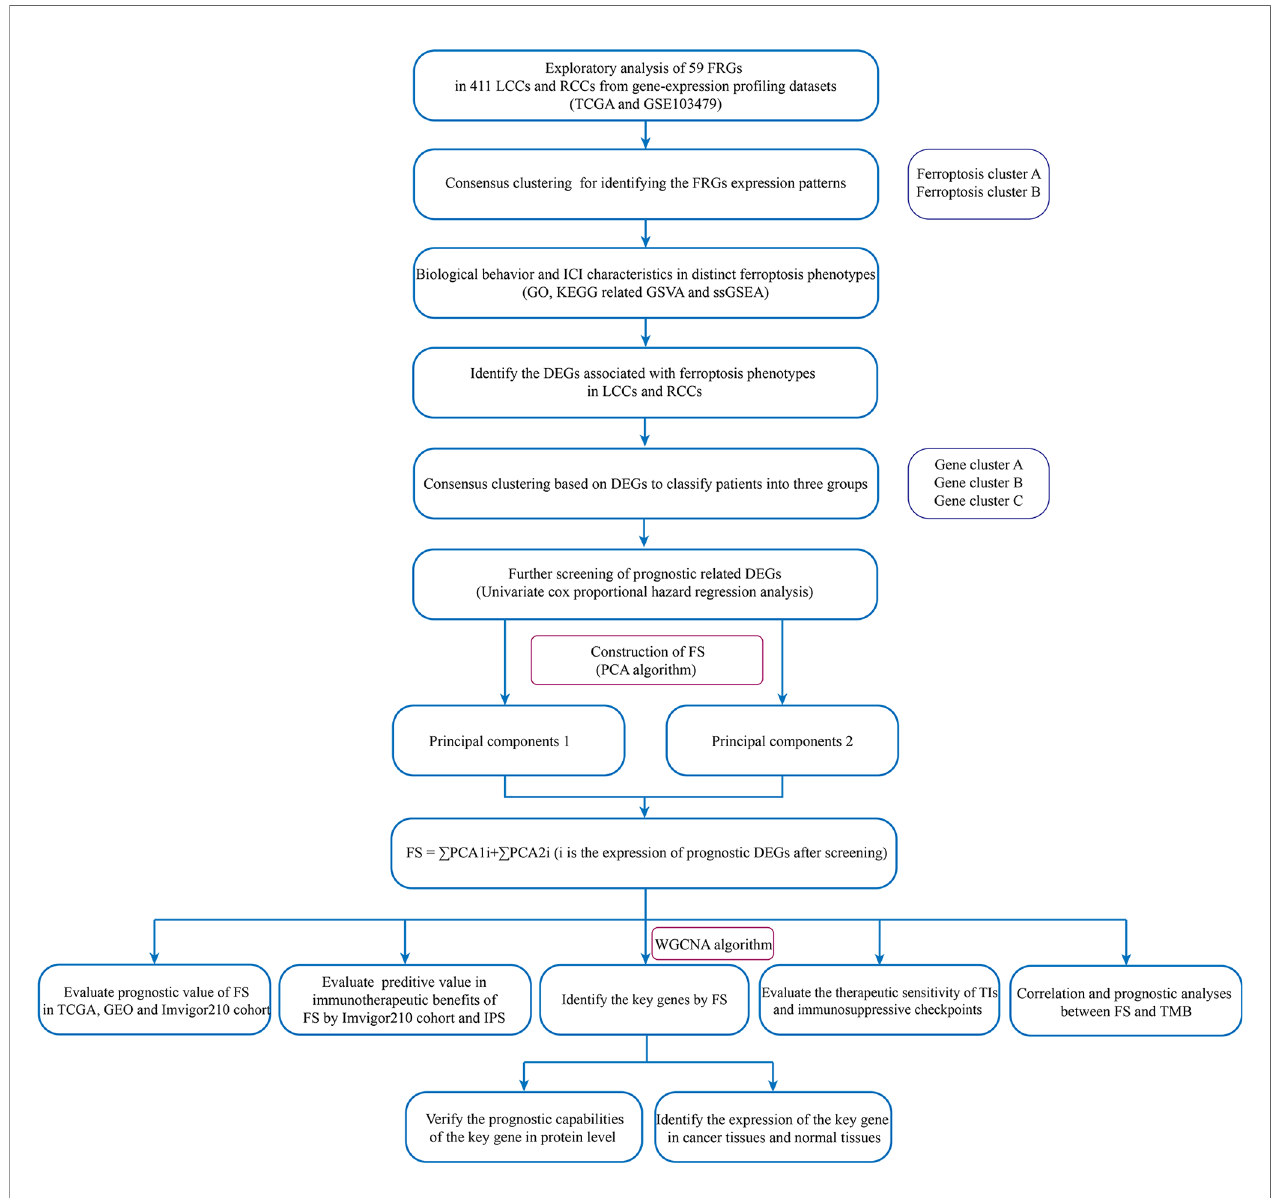
FIGURE 1 | The fl owchart of the entire